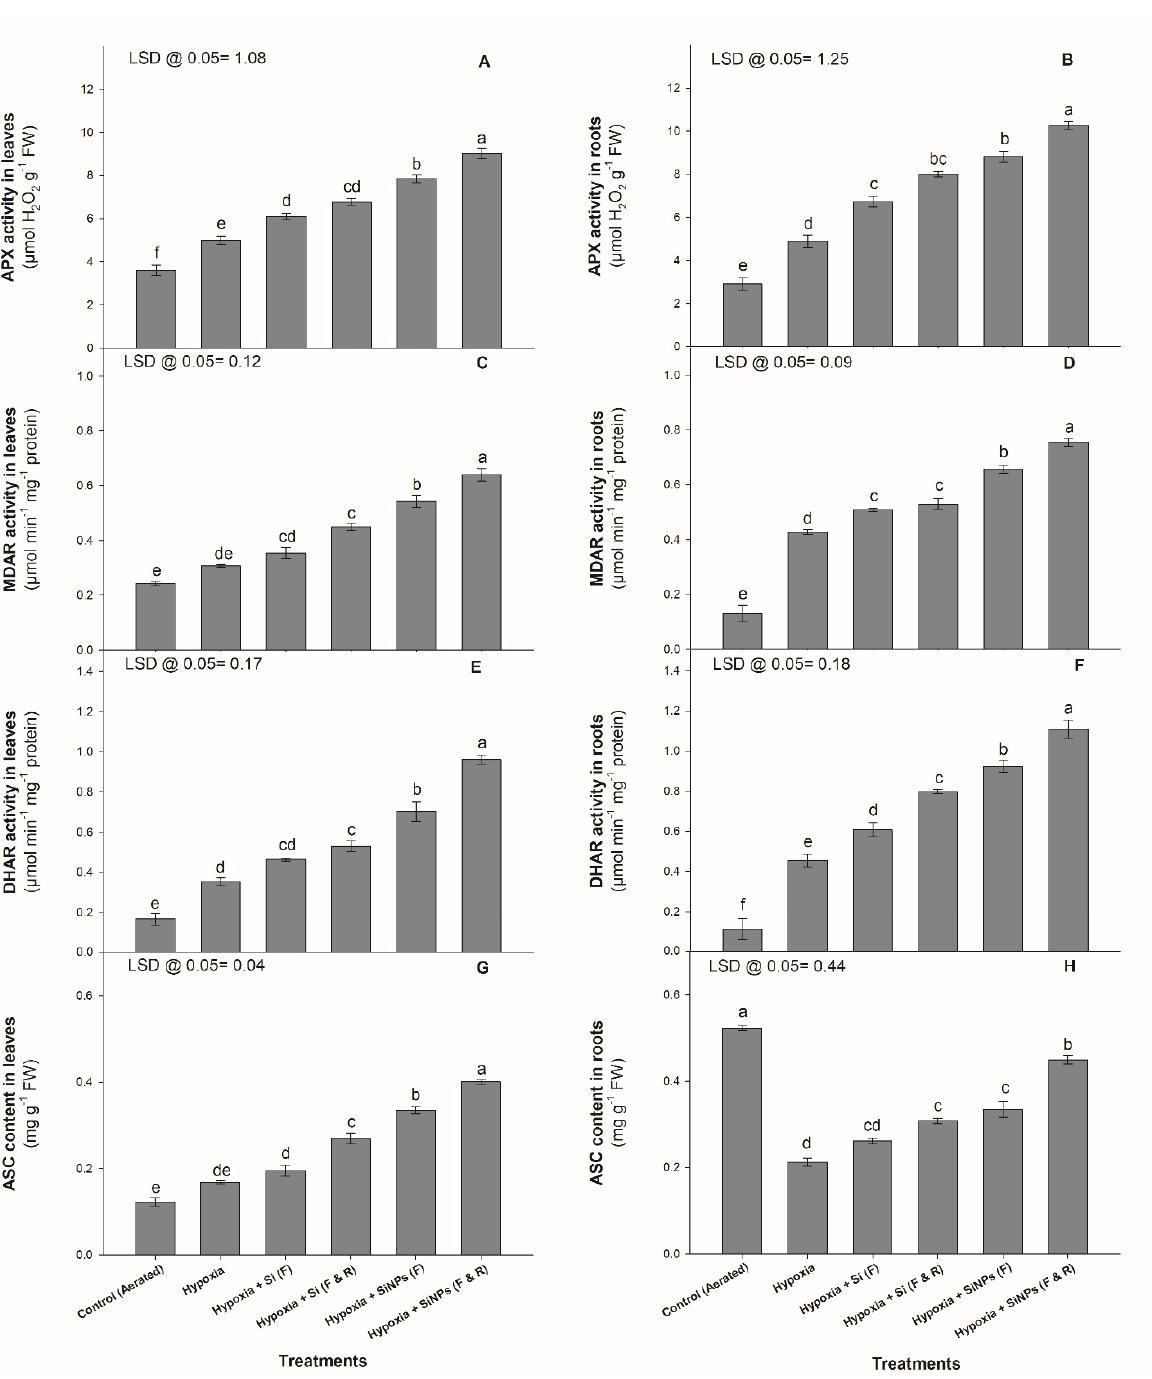
Figure 4. APX activity ( A , B ), MDAR activity ( C , D ), DHAR activity ( E , F ), and ASC content ( G , H ) in leaves and roots of blueberry plants in response to six treatments i.e., (i) control (aerated), (ii) hypoxia, (iii) hypoxia + Si (F), (iv) hypoxia + Si (F & R), (v) hypoxia + SiNP (F), (vi) hypoxia + SiNPs (F & R). Values are mean of four independent replicates ( n = 4) ± SE (shown in vertical bars), and values denoted by different letters (in small alphabets) differ significantly at p < 0.05, using the LSD test. The abbreviations used are ASC: ascorbic acid; APX: ascorbate peroxidase; DHAR: dehydroascorbate reductase; F: foliar application of Si or SiNP; F & R: combined foliar and root zone application of Si; MDAR: monodehydroascorbate reductase; R: root zone application of Si or SiNP; Si: conventional silicon; SiNPs: silicon